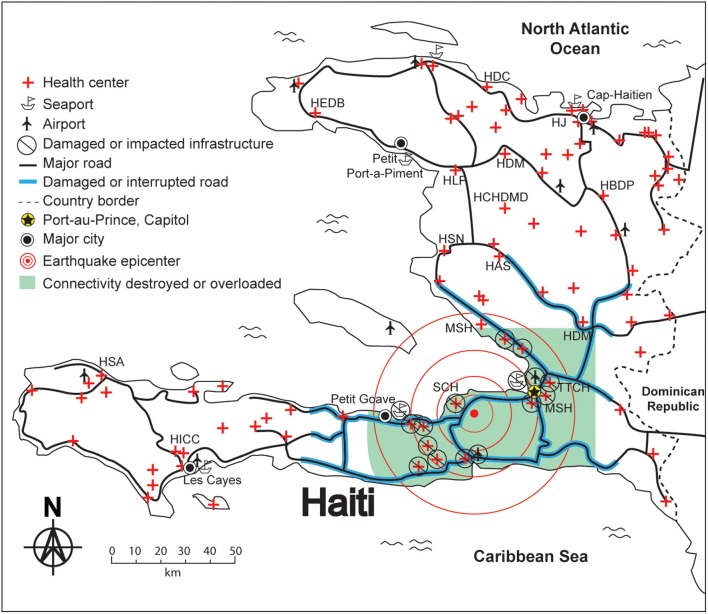
Geographic isolation by the Haiti Earthquake—need for spatial resilience. The circles show the earthquake epicenter. Bold lines show damaged or interrupted roads. United States Disaster Medical Assistance Teams carried suitcase size (<50 lbs) sets of POC diagnostics, but larger instruments transported to Haiti could not be used because there were no trained operators who could perform quality control. In settings like this one, communities should develop their own plans for resilience that include mobile POCT and properly trained, certified, and annually validated personnel. These resources should be placed at local nodes, clusters, or hubs in the SWN to assure optimal resilience. Image reproduced with permission of Knowledge Optimization.